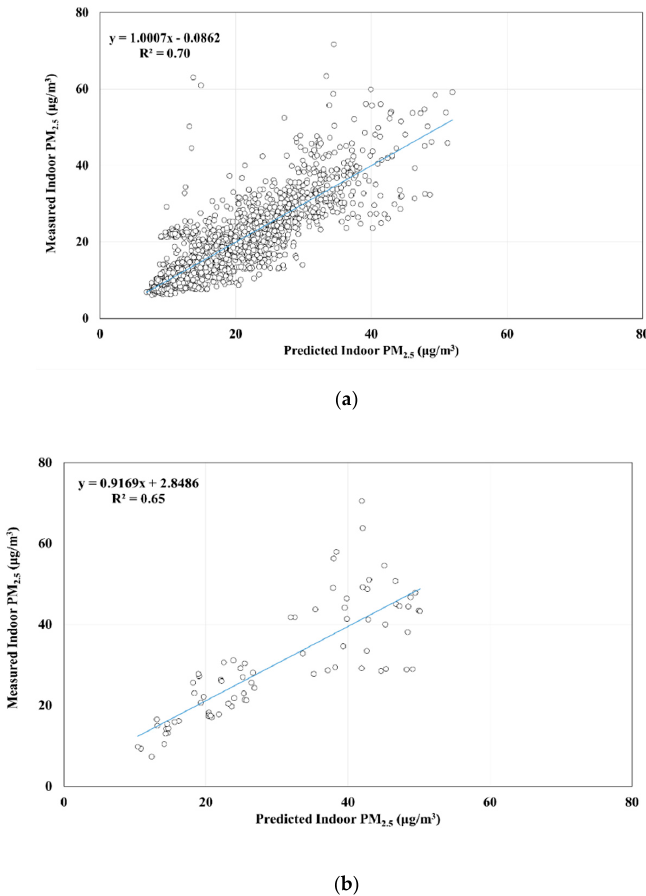
Figure 4. Relationship between predicted and measured hourly average indoor PM 2.5 concentration across areas: ( a ) urban and ( b ) nonurban areas.